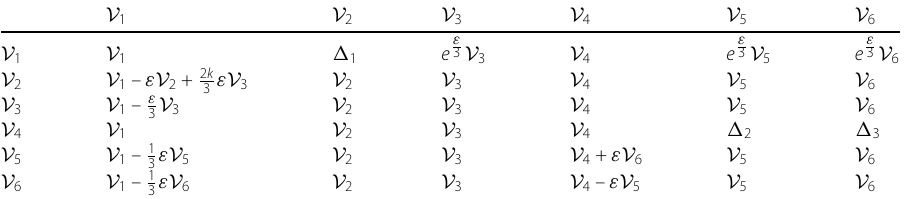
Table 2 Adjoint representation of the Lie algebra of Eq.